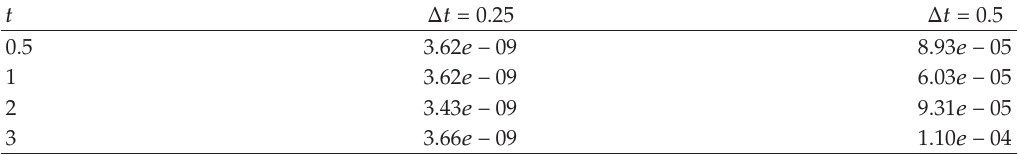
Table 5: Relative errors of Problem 2 using N (cid:6) M (cid:6) 21 using FDQ. t Δ t (cid:6) 0 .